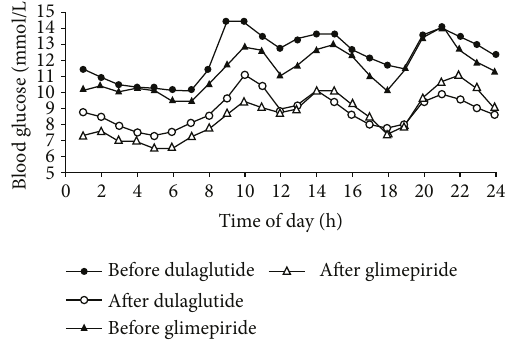
Figure 1: 24h CGMS glucose fl uctuation pro fi le of patients having dulaglutide or glimepiride.